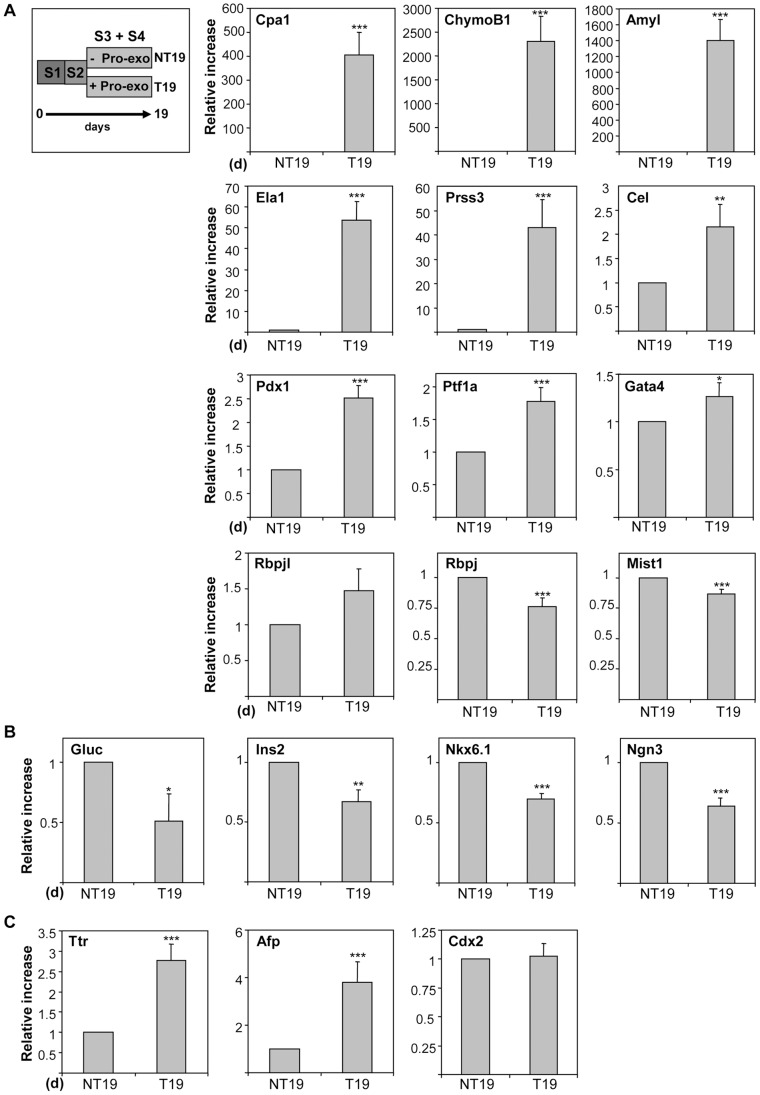
Expression of pancreatic differentiation markers by qRT-PCR at stage 4.Cells were induced to differentiate through-out the whole protocol as indicated in Fig. 1 and analyzed by qRT-PCR for the expression of exocrine (A), endocrine (B) or hepatic (C) markers. Histograms show the relative expression levels normalized to the loading control Hprt. Error bars indicate the SEM of at least 3 experiments. Marker expression at day 19 (T19) was compared to non-treated cells after stage 2 induction and cultured during the same period of time (NT19) to specifically study the effect of the pro-exocrine molecules. p, as compared to NT19.